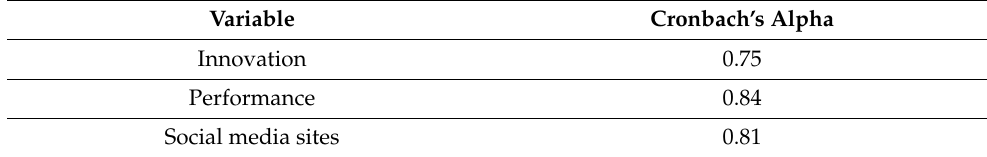
Table 2. Cronbach’s alpha values.